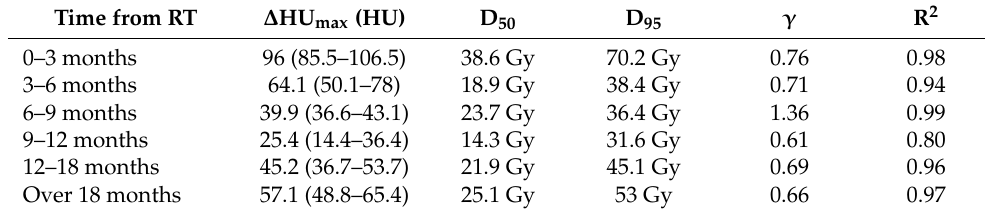
Table 2. Parameters ∆ HU max , D 50 , D 95 , γ , and R 2 of the sigmoidal fit to achieved data points.